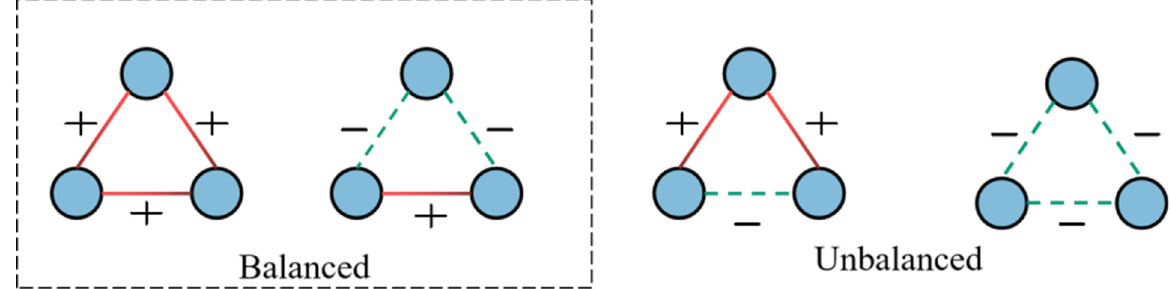
Figure 1. Balance and unbalance relations in a signed network.